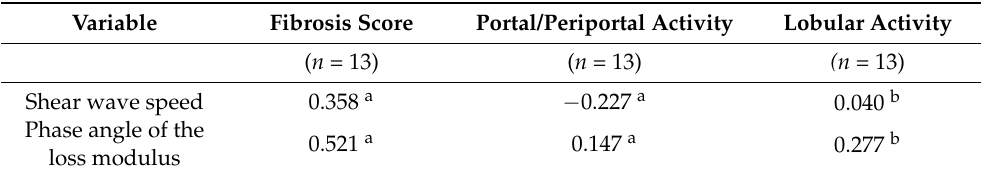
Table 4. Correlation analysis between liver tomoelastography and histopathological scores. Variable Fibrosis Score Portal/Periportal Activity Lobular Activity ( n = 13) Shear wave speed 0.358 a 0.040 b Phase angle of the 0.521